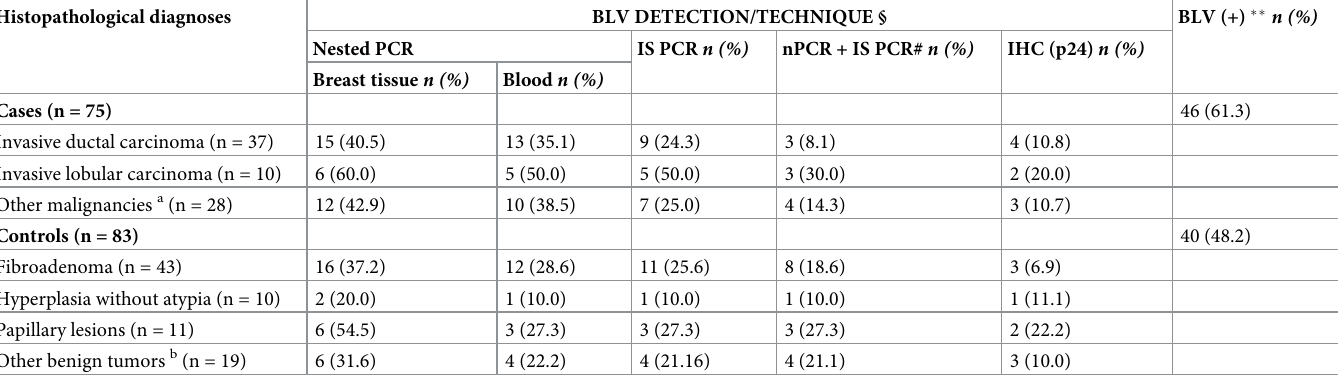
Table 2. Histopathological diagnoses and viral